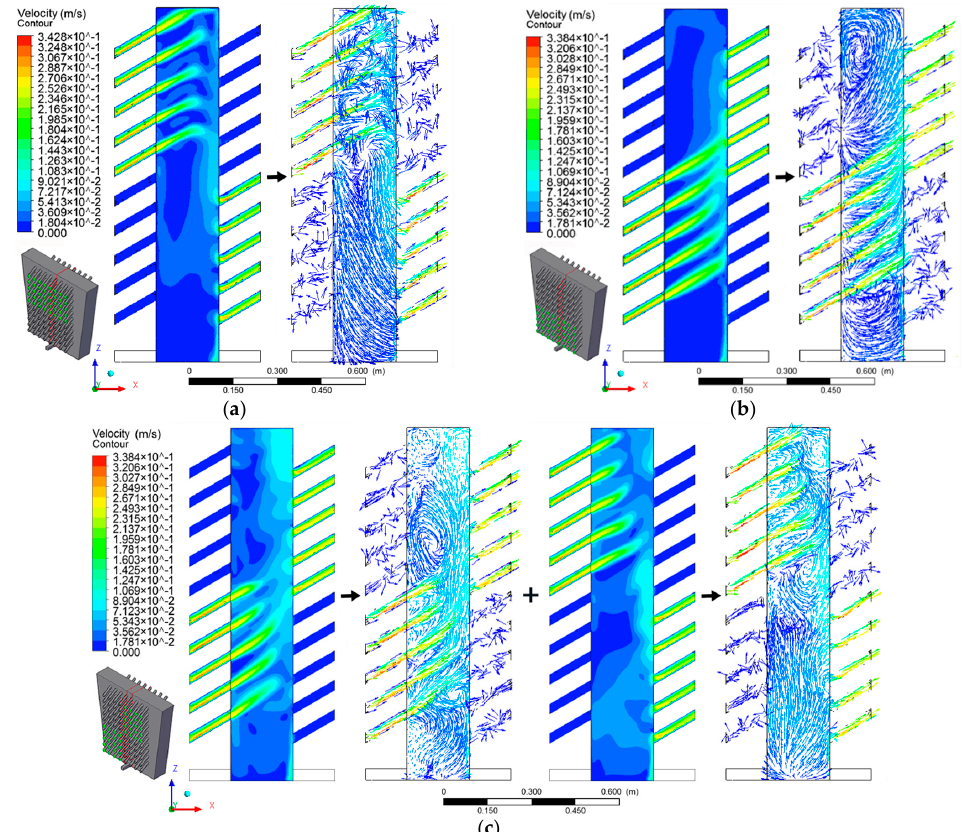
Figure 6. Vector and contour graphs of the flow field between the baffles in the tundish with MHDB in different hole array modes. ( a ) UILO mode; ( b ) LIUO mode; ( c ) X mode.